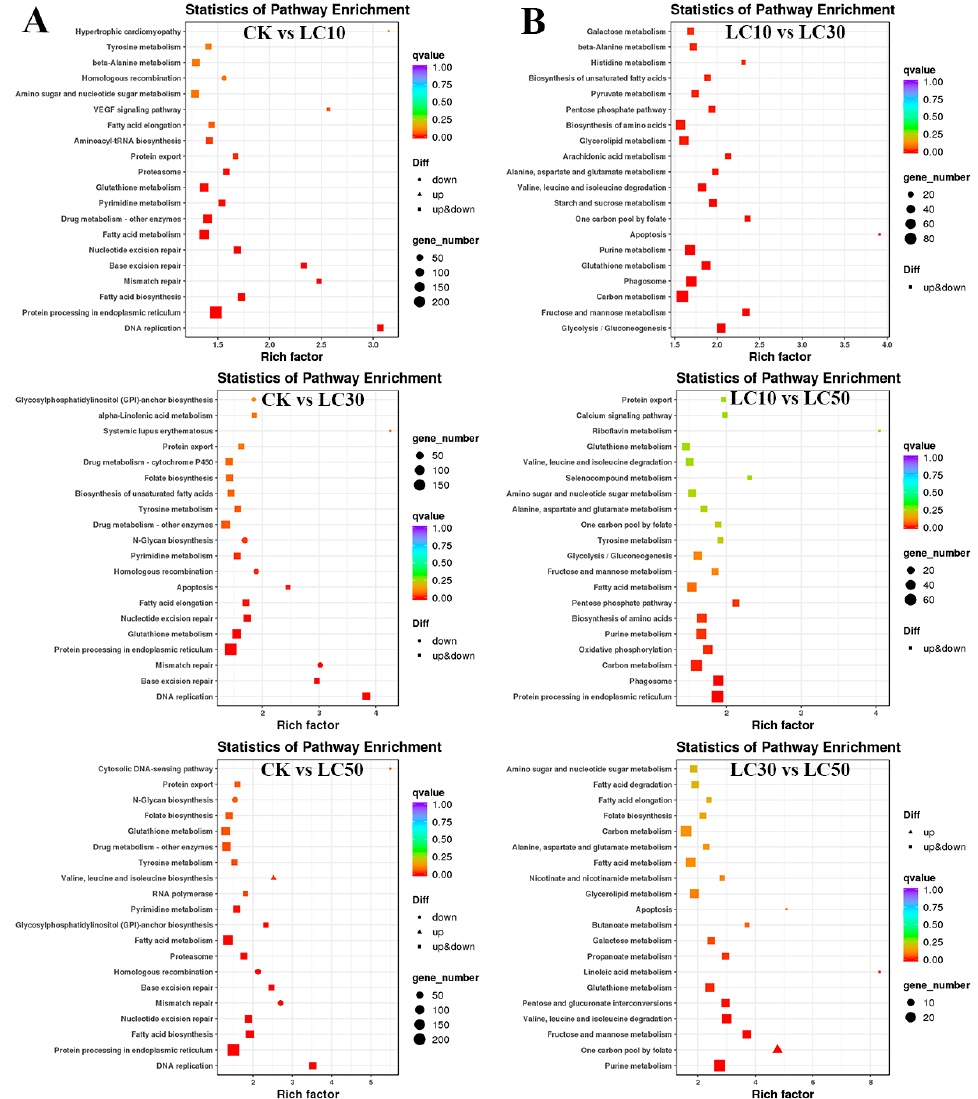
Figure 3. KEGG enrichment analysis of DETs compared between different concentrations. Subfigure ( A ) represents the enrichment results between CK and each treatment group, and subfigure ( B ) represents the enrichment results between the treatment group and the treatment group. The round dot indicates down-regulated genes, the triangle indicates up-regulated genes, and the square indicates both up-regulated and down-regulated genes. The abscissa represents the enrichment factor; the larger the enrichment factor, the more significant the enrichment level of the differentially expressed transcripts in this pathway. The q-value is the p value after correction for multiple hypothesis testing. The smaller the q-value, the more reliable the enrichment significance of the differentially expressed transcripts in this